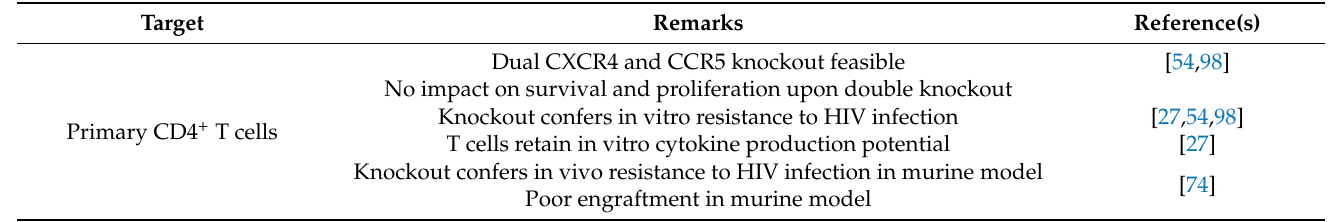
Table 4. CRISPR-mediated simultaneous gene editing of CCR5 and